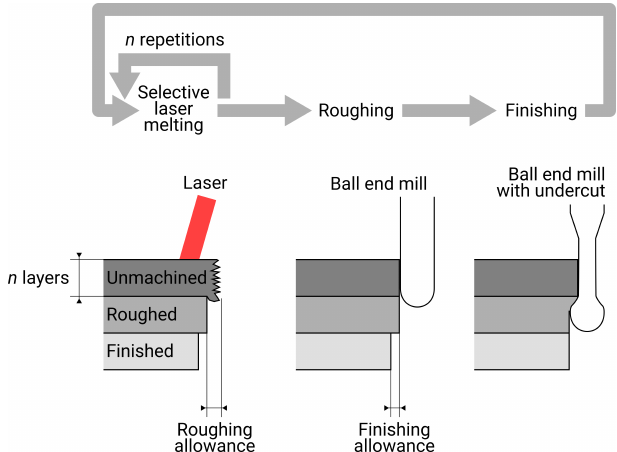
Figure 2. Sequence of a hybrid AM process consisting of selective laser melting and milling according to Nojiri et al. [16]